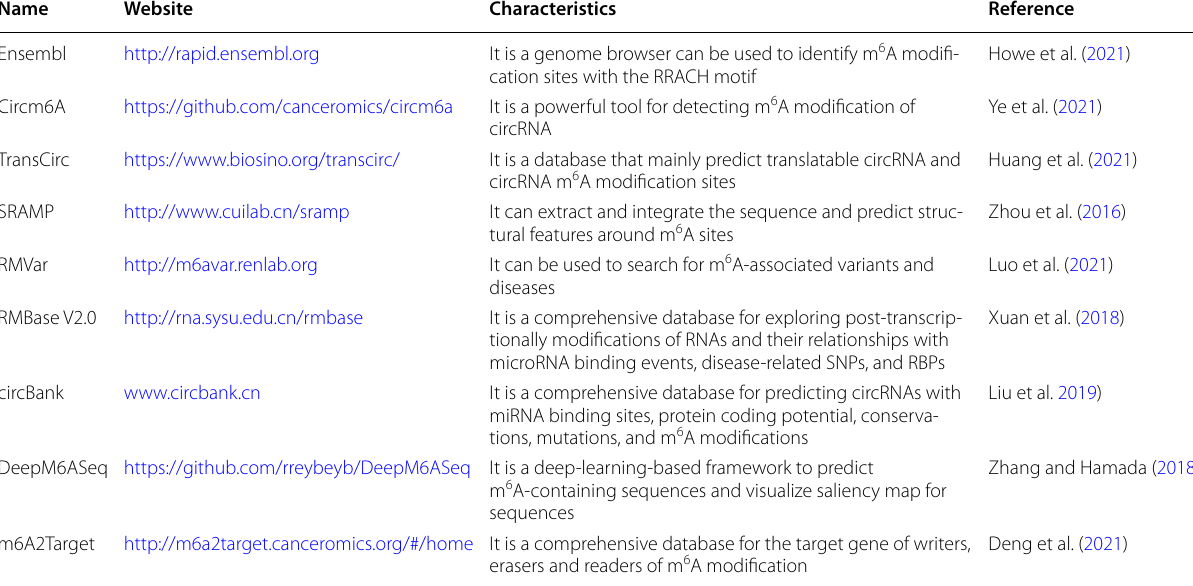
Table 2 Databases for predicting m 6 A-modified